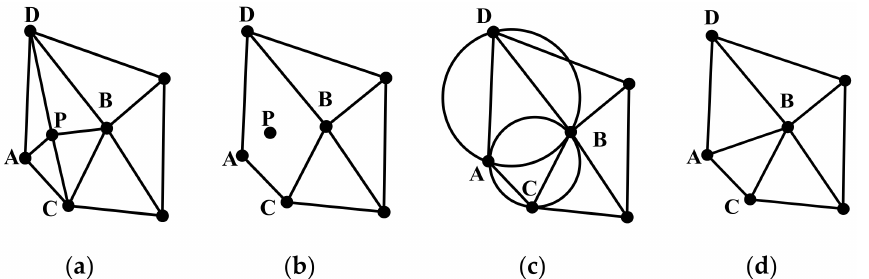
Figure 3. Insert construction method: ( a ) robot P has a health value of zero; ( b ) delete the public edge related to P; ( c ) re-plan neighboring robots; ( d ) form a new distribution. The specific control Algorithm 2 steps in this study were as Algorithm 2. Algorithm 2: CVT-based multi-robot formation control and health optimization management Algorithm